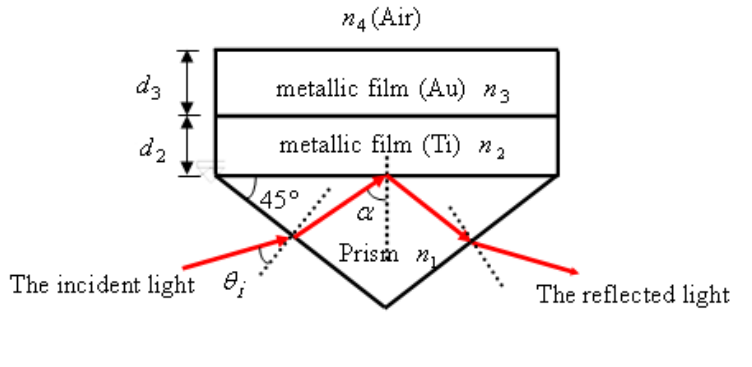
Figure 2. Kretchmann’s configuration for the generation of